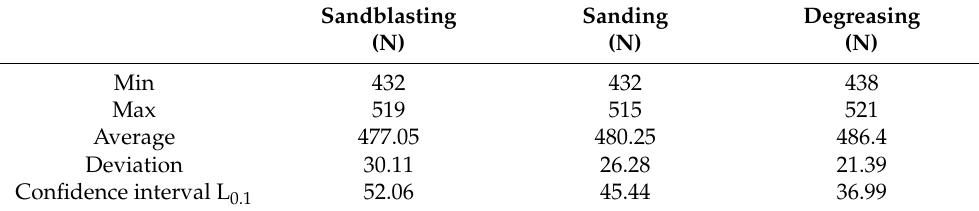
Table 4. Influence of the preparation of the surface to be bonded the bonding strength of the joint.